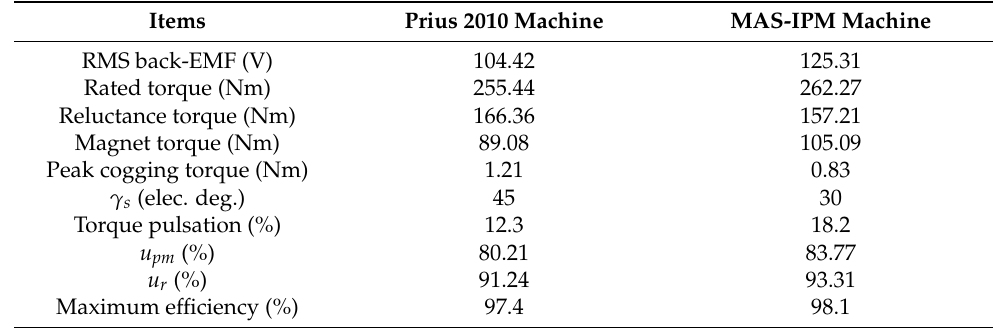
Table 3. The electromagnetic performance of the two investigated